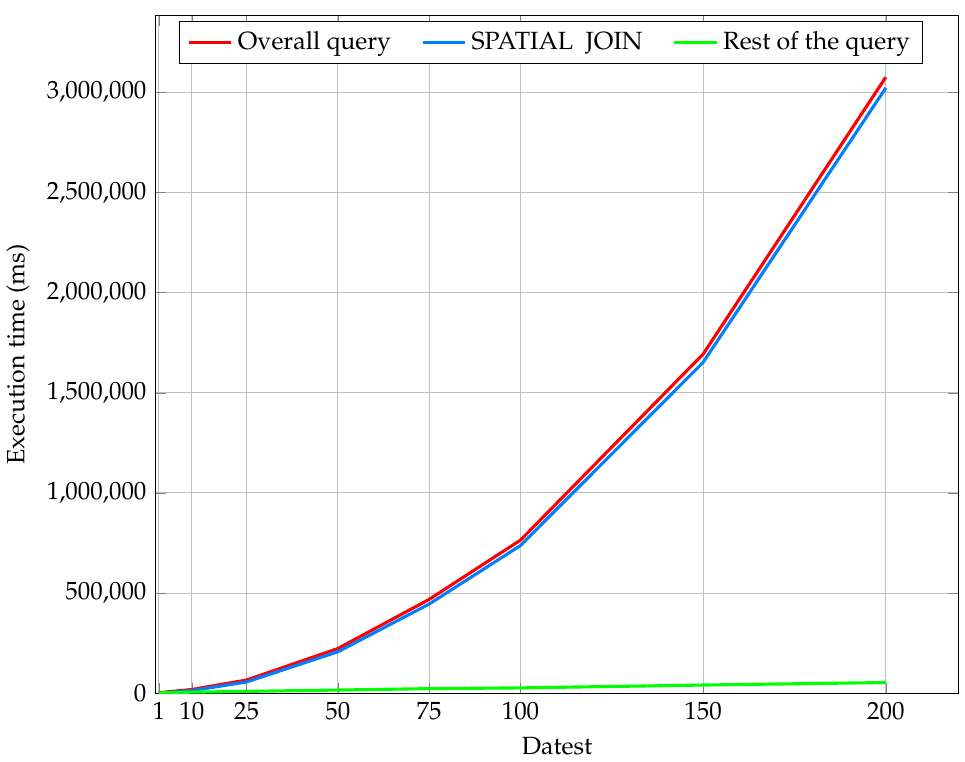
Figure 7 plots the execution times, with respect to the size of the data sets. On the x axis, we report the multiplication factor f we used to generate each single data set. Three lines are plotted: the red line shows the overall execution times; the blue line shows the execution time taken by the SPATIAL JOIN instruction; the green line shows the overall execution time without the time taken by the SPATIAL JOIN instruction. The three lines clearly show how the execution time is dominated by the SPATIAL JOIN instruction. In fact, the rest of the query (green line) scales very well and its contribution becomes substantially negligible for the large data sets.